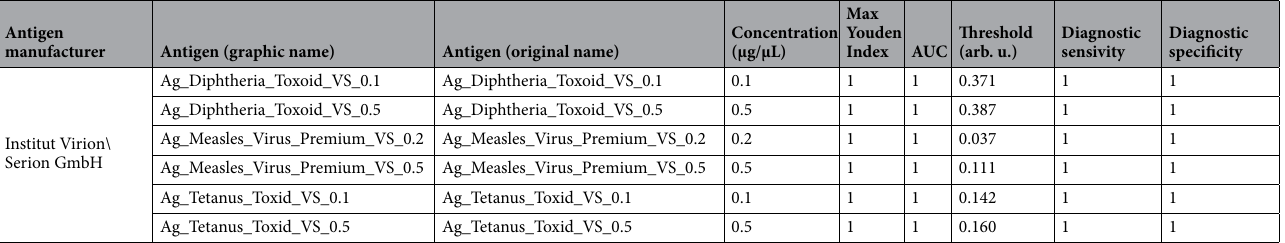
Table 1. Listed are the antigen manufacturer, antigen graphic and original names, calculated AUCs and Youden indices, threshold values, diagnostic sensitivities and specificities for each immobilized antigen concentration tested in the corresponding